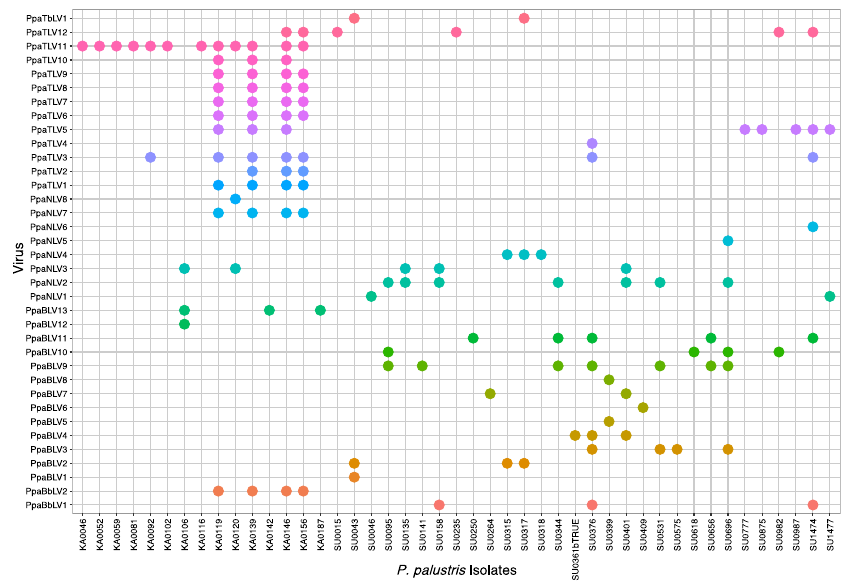
Figure 7. ( a ). Map showing the sites of the virus-hosting “ P.palustris” isolates in Sumatra. ( b ). Map showing the sites of the virus-hosting “ P. palustris ” isolates in Kalimantan. The pie charts illustrate the relative frequency of each virus family/order in Sumatra and Kalimantan.